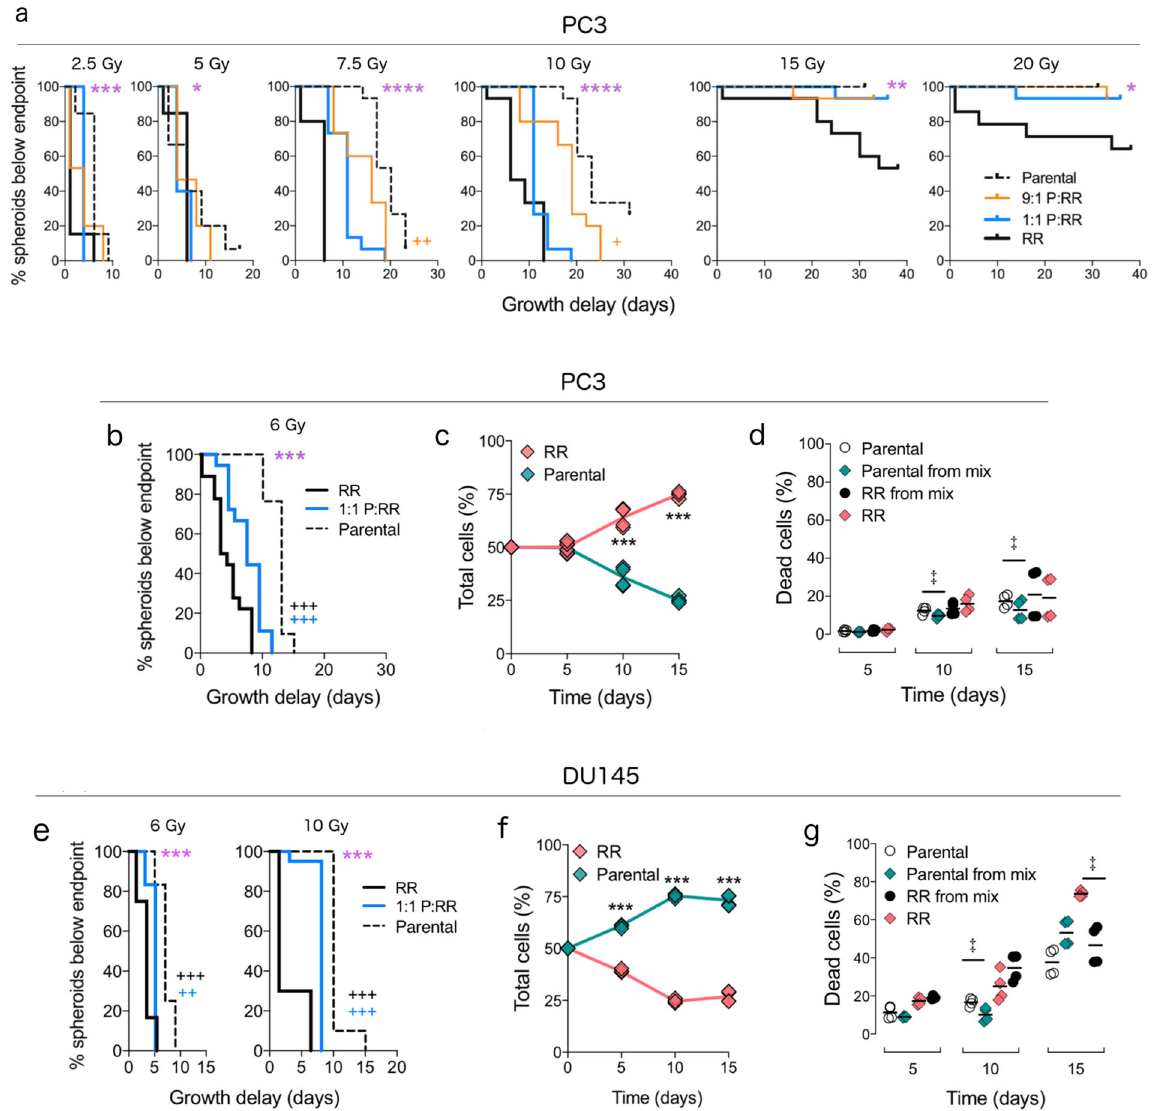
Fig. 4 Inclusion of radioresistant populations in spheroids reduces radiation sensitivity. a Survival curves of time (days) taken for irradiated PC3 spheroids seeded with 100% parental (dashed black line), 9:1 parental:radioresistant (P:RR, orange line), 1:1P:RR (blue line) or 100% RR (black line) cells to reach endpoint, adjusted for the time taken by untreated spheroids to reach the same endpoint ( n = 15 spheroids/group/radiation dose from 1 batch). *** P adj < 0.001, global log-rank test for all survival curves; + P adj < 0.05, ++ P adj < 0.01, log-rank test comparing survival curves of parental vs. 9:1P:RR (orange crosses). b , e Survival curves of time (days) taken for irradiated PC3 (6 Gy) and DU145 (6 and 10 Gy) spheroids seeded as parental (dashed black line), 1:1P:RR (blue line), or RR (solid black line) to reach the endpoint, adjusted for the time taken by untreated spheroids to reach the same endpoint ( n = 17 spheroids/group for PC3 pooled from 3 batches; n = 12 spheroids/group for 6 Gy DU145 spheroids pooled from 2 batches; n = 20 spheroids/group for 10 Gy DU145 spheroids from 1 batch). *** P adj < 0.001, global log-rank test for all survival curves; ++ P adj < 0.01, +++ P adj < 0.001, log-rank test comparing parental vs. 1:1P:RR (blue crosses) and parental vs. RR (black crosses) spheroids. c , f Proportions of parental (green diamonds) and RR (pink diamonds) populations measured over time using fl ow cytometry from spheroids seeded as 1:1 mixture and irradiated ( n = 4 experiments, *** P adj < 0.001, 2-way ANOVA with Sidak correction). Lines connecting symbols indicate the median value. d , g Percent of dead cells in each population isolated from irradiated homogeneous spheroids (parental, white circles; RR, black circles) or from mixed spheroids (parental, green diamonds; RR, pink diamonds) seeded as a 1:1 mixture of parental:RR ( n = 4 experiments). Bar indicates mean value. ‡ FDR < 0.05, overdispersed binomial regression with Benjamini – Hochberg correction. No P value was calculated for parental populations from DU145 spheroids on day 15 due to a poor model fi t.